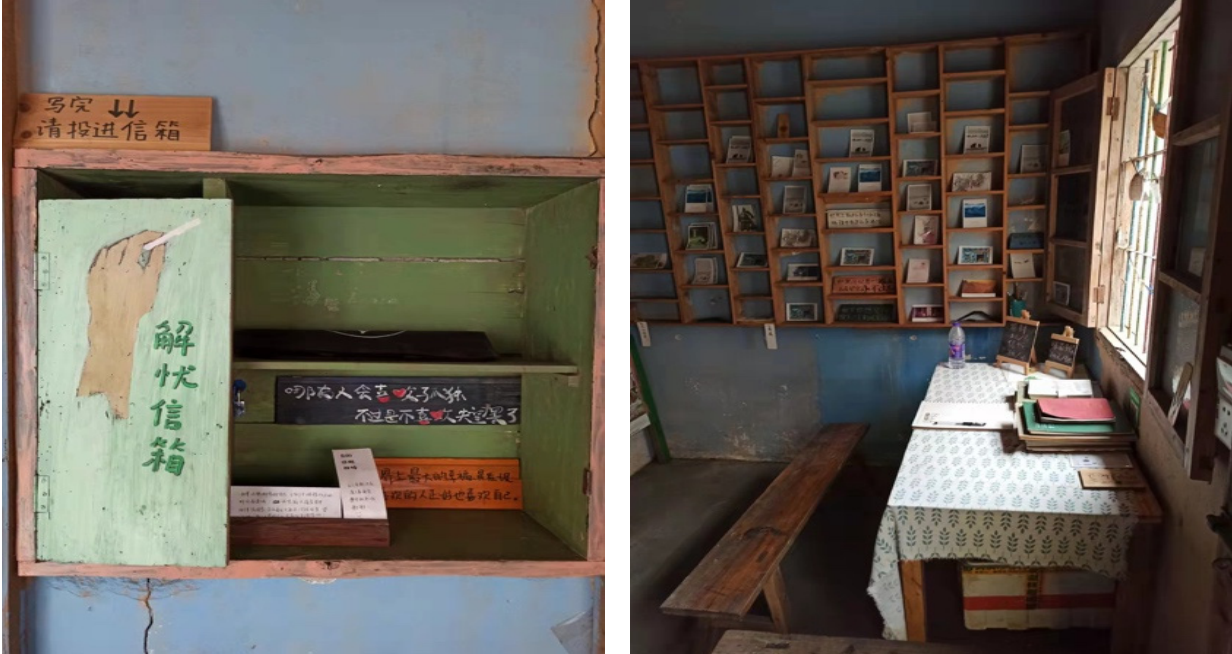
Figure 3. Message board in Xidi’s unattended grocery store (photograph by the first author). Note: On the left is a ‘remove sorrow’ mailbox.